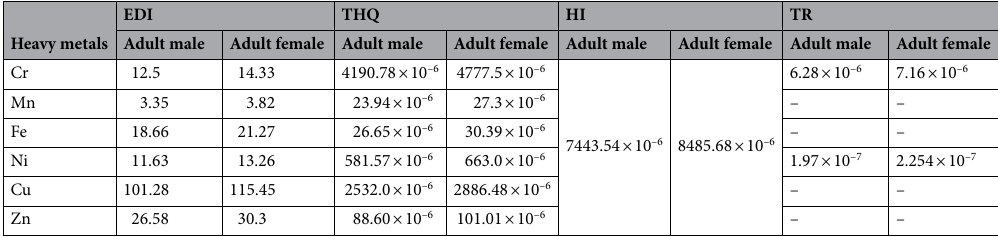
Table 4. Human health risk assessment parameters (EDI, THQ, HI and